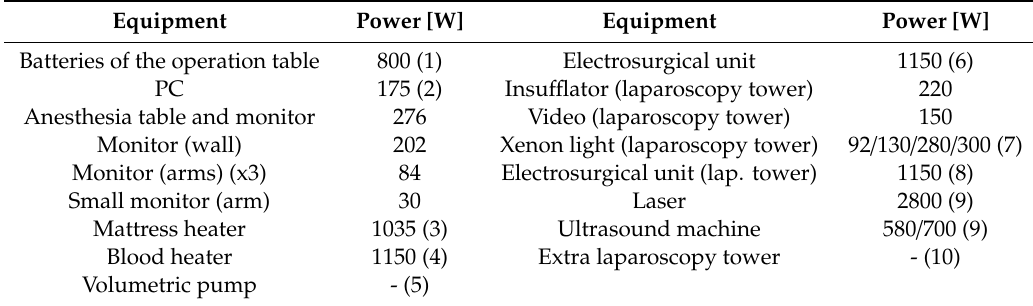
Table 2. Power consumption in the operating